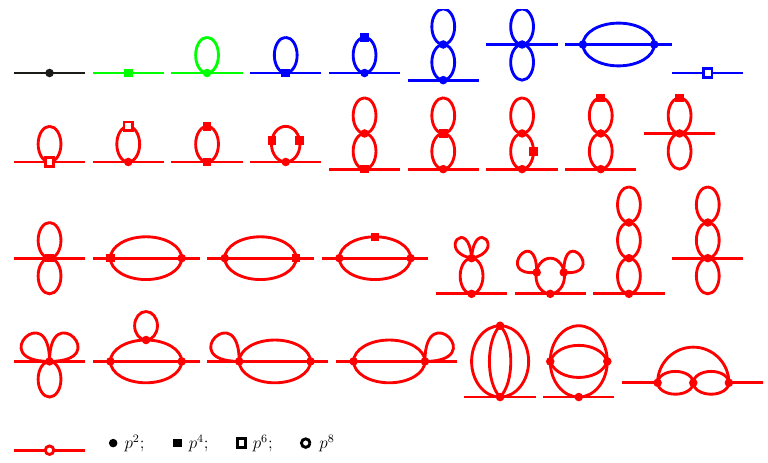
Figure 1. The 34 diagrams contributing to (cid:6). The (cid:12)rst one is LO, the next two NLO, the next 6 NNLO, all in the (cid:12)rst line. The remaining diagrams are those needed at